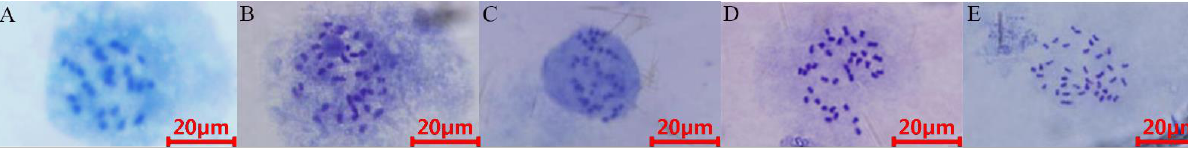
Figure 3. Images of natural triploids and diploid of jujube. ( A ) Linyilizao (diploid), ( B ) QXPGZ; ( C ) TGDGHPZ; ( D ) JSNYDBZ; ( E ) LXEBCSZ